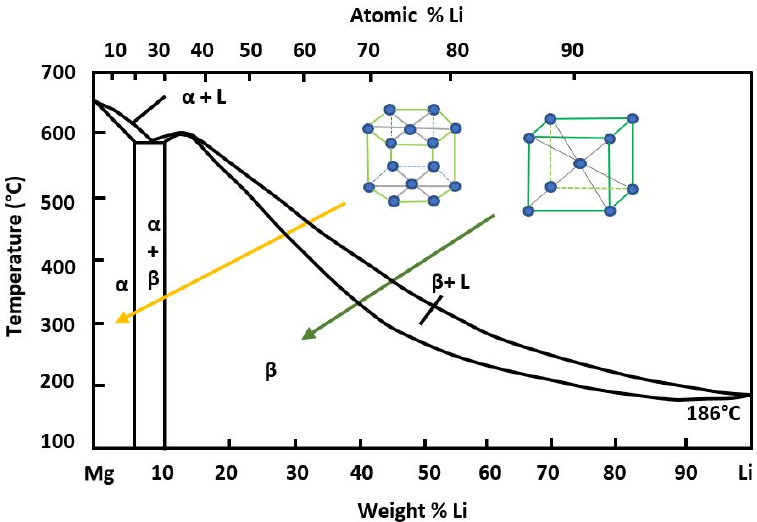
Figure 1. Magnesium-lithium phase diagram (made on the basis of data contained in [32]).